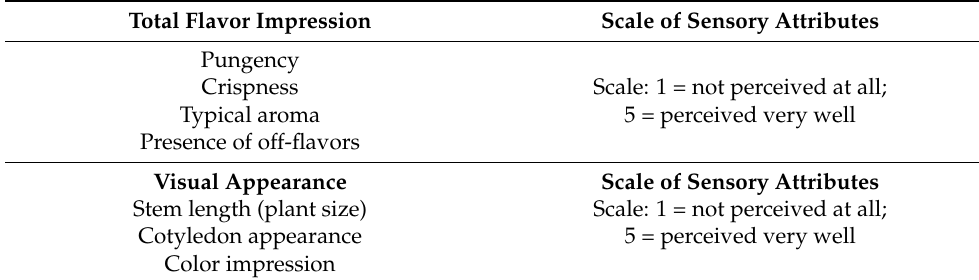
Table 3. Sensory attributes and acceptability items collected during the consumer test. Radish cress and garden cress were assessed by means of four flavor impressions and three visual